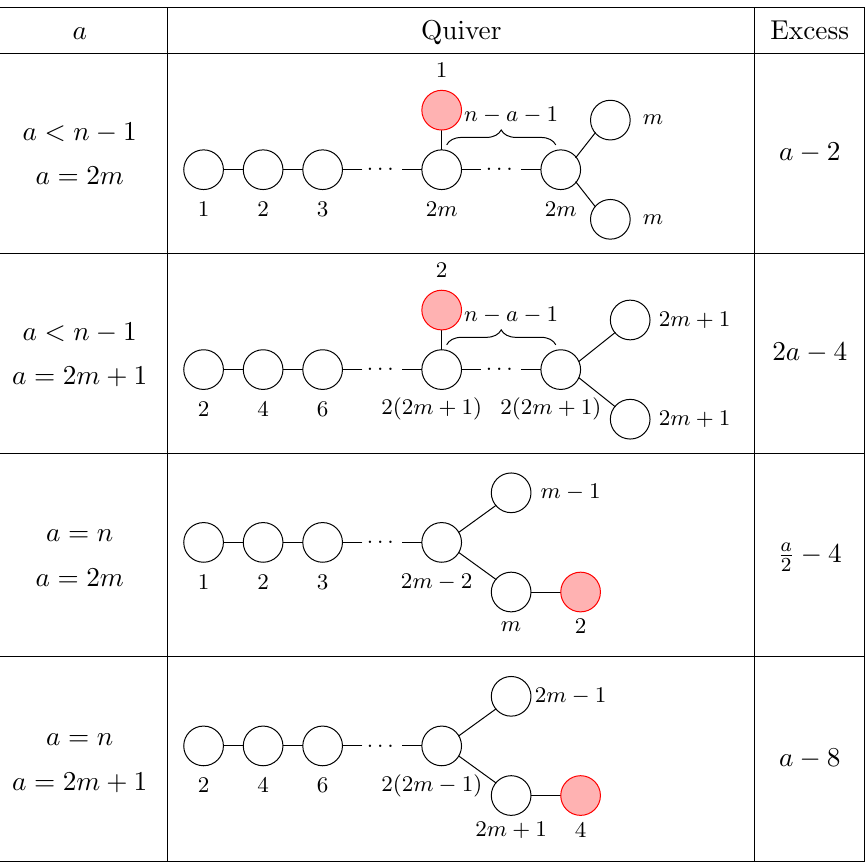
Table 3 . Classi(cid:12)cation of minimally unbalanced quivers with G = SO(2 n